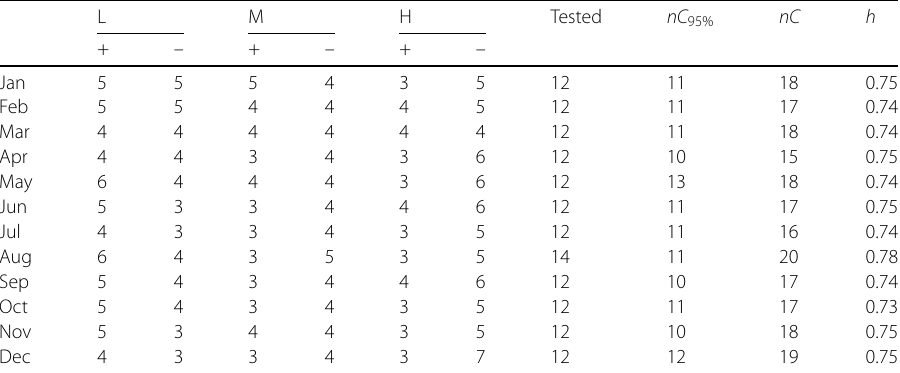
Table 15 Summary for test results: